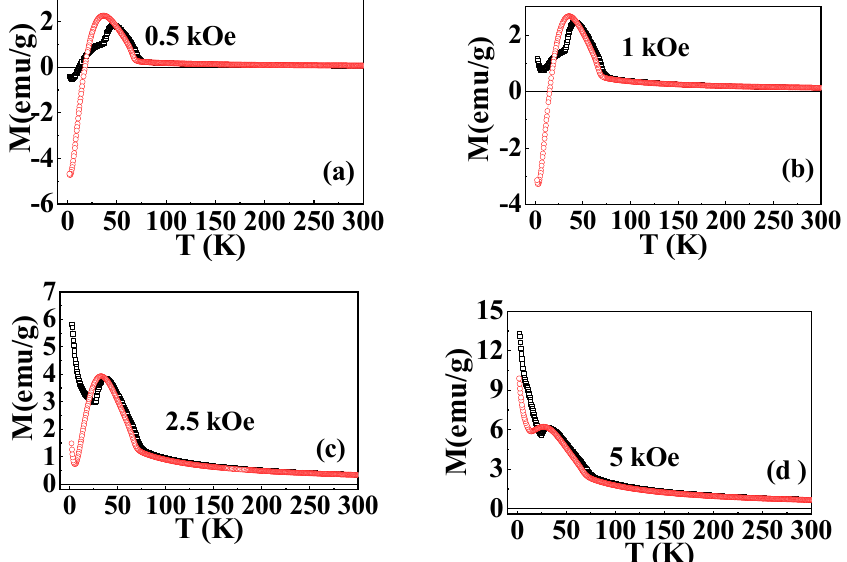
Figure 5. ( a – d ): ZFC and FC magnetization curves of x = 0.5 compound measured under 500 Oe, 1 kOe, 2.5 kOe and 5 kOe magnetic field.